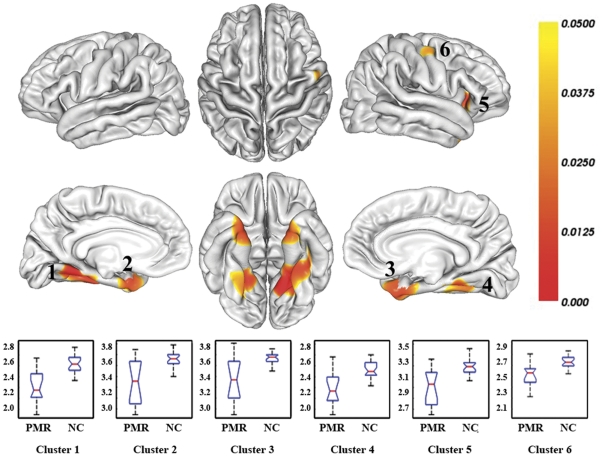
Brain regions with cortical thickness reductions in mental retardation and distribution of average cortical thickness (in mm) of each corresponding region.The results were corrected for multiple comparisons (P<0.05, the vertex-based RFT correction). The color bar indicates the corrected P-values. The integers are the cluster IDs corresponding to those of Table 1. Normal controls, NC; Patients with mental retardation, PMR.